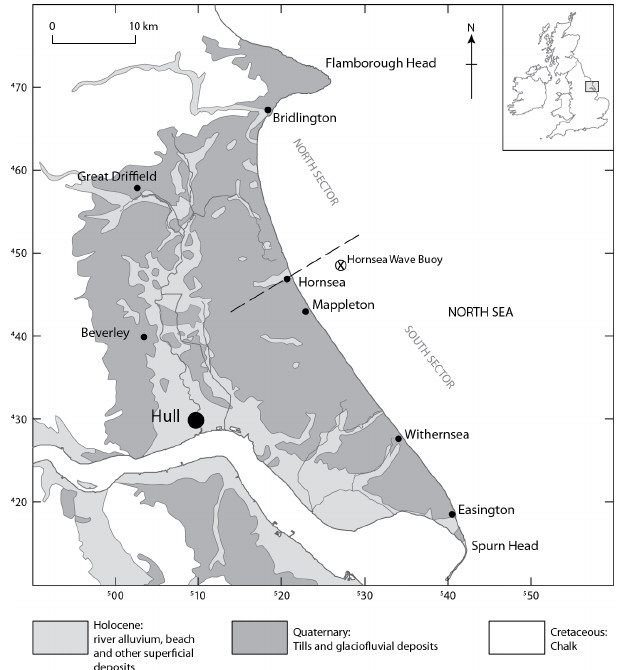
Figure 1. Geological composition of the Holderness coast (main) and the location of the region within the UK (insert). Also indi- cated are the positions of the Hornsea wave buoy, from which wave climate was recorded, and the division into northern and southern coastline regions, as referenced by the sea wall at Hornsea (dashed line), to aid